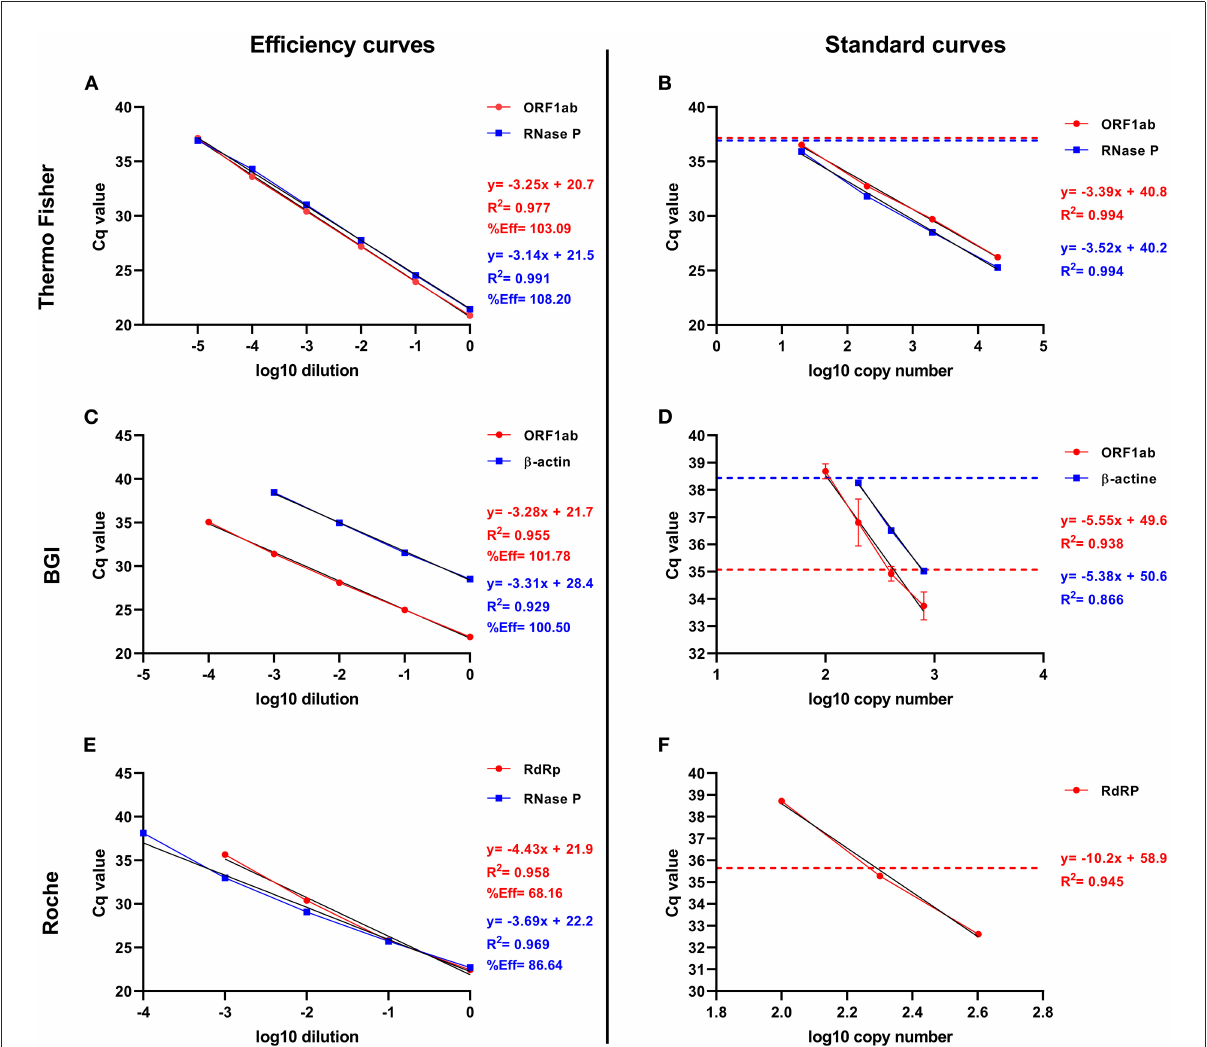
FIGURE4 Efficiency and standard amplification curves to determine probe efficiency, Cq cut-off, and genome copies number for the Thermo Fisher, BGI, and Roche RT-qPCR kits. The left and right columns show the efficiency and the standard curves, respectively. The graphs represented the information about the viral and IC probes with red and blue colors, respectively. (A) Efficiency curve for ORF1ab and RNase P probes from Thermo Fisher RT-qPCR kit. (B) Standard curve for ORF1ab and RNase P probes from Thermo Fisher RT-qPCR kit. (C) Efficiency curve for ORF1ab and β -actin probes from BGI RT-qPCR kit. (D) Standard curve for ORF1ab and β -actin probes from BGI RT-qPCR kit. (F) Efficiency curve for RdRp probe from Roche RT-qPCR kit combined with RNase P probe from Thermo Fisher RT-qPCR kit. (E) Standard curve for RdRp probe (Roche RT-qPCR kit). The standard curve for the IC probe from the Roche kit was not plotted because the RNase P probe from the Thermo Fisher kit was used in the Roche RT-qPCR reaction, and the Roche positive control is recognized by the Equine Arteritis Virus (EAV) probe. The graphs represent the linear equation (y = a + bx, b = slope, and a = y-intercept), R-squared (R 2 ), and the percentage probe efficiency (%Eff). The broken line indicates the value at which the Cq cut-off was set for each probe assessed for Thermo Fisher (CqRNaseP = 36.92; Cq ORF1ab = 37.15), BGI (Cq β -actin = 38.44; Cq ORF1ab = 35.07), and Roche RT-qPCR kit (Cq RdRp =